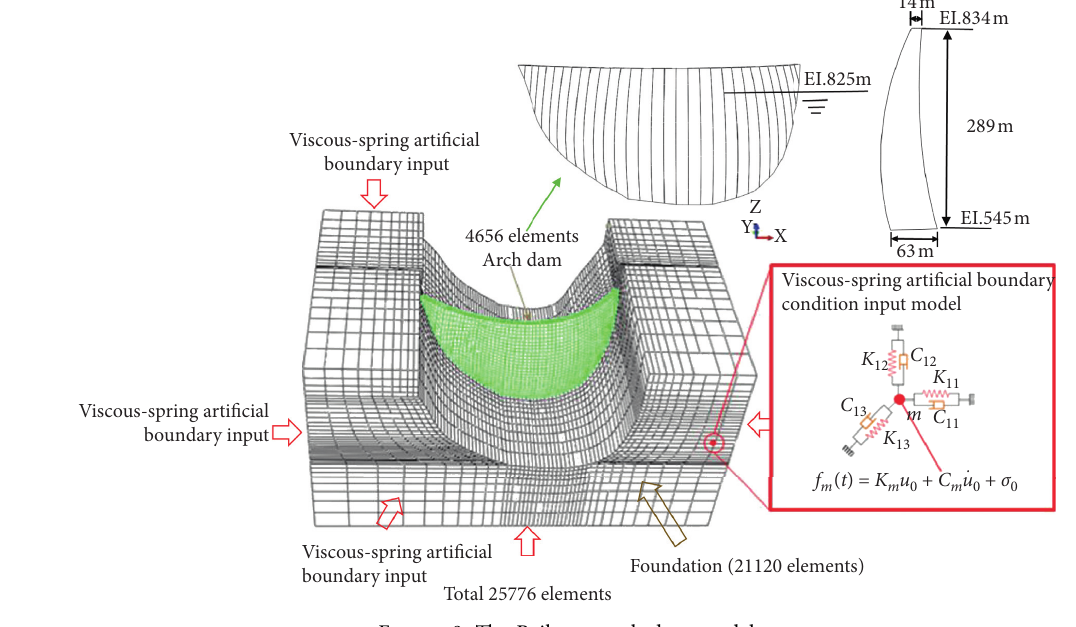
Figure 8: The Baihetan arch dam model.